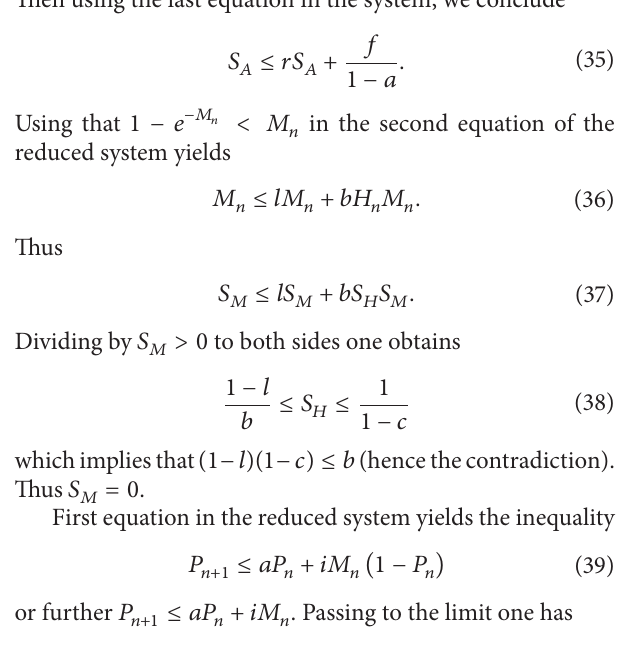
In the region of existence of positive equilibrium point, 𝑏 > (1 − 𝑐)(1 − 𝑙) , the values of parameters for which the